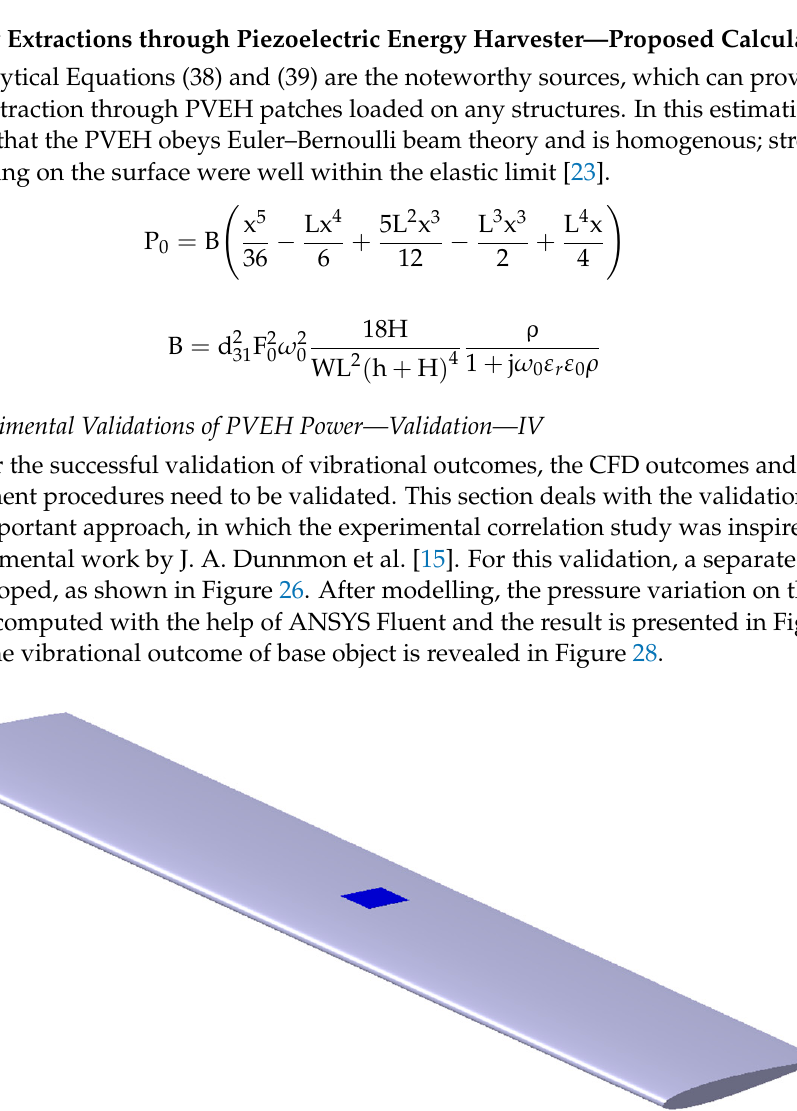
Figure 28. Vibrational outcomes of base aircraft wing for experimental validation. Based on Equations (38) and (39), electrical developments were validated with experimental outcomes [15] and thereby the comprehensive results were compared for further validation. The experimental result of developed electrical power was 2.5 mW and the results of developed electrical power through this proposed approach is 2.58 mW. With the help of known conventional calculation, the error percentage was calculated. The obtained error percentage is 3.1% and it falls within the acceptable range; therefore, the proposed approach that combined computational and analytical methods can provide reliable outcomes [39–45].